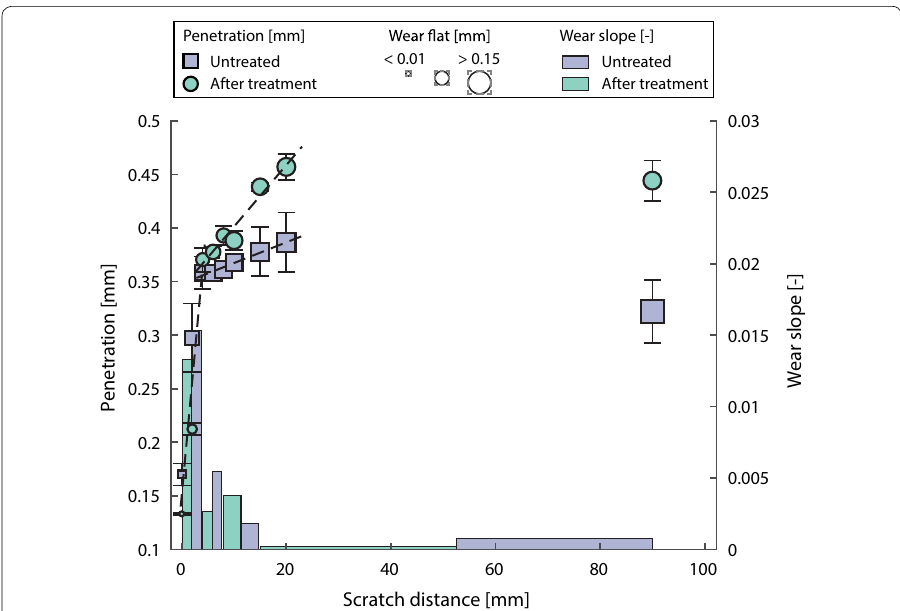
Fig. 3 Tool penetration and wear flat in sandstone. Tool penetration during testing of Rorschach sandstone is shown, with the scattered data and the left y -axis for untreated (violet squares) and after treatment (green circles). The symbol sizes represent the wear flattening of the cutting tool (see legend in the figure). The bi-linear regressions of the tool penetration values along the scratch distance are shown as dashed black lines. As a bar plot, we also include the wear flat increase per unit of scratch distance, here called wear slope, where the values are provided by the right y -axis. The bars indicate the wear slope for untreated (violet) and after-treatment (green) conditions, shown as contiguous columns for the scratch distance ranges 0–4 mm, 4–8 mm, 8–15 mm and 15–90